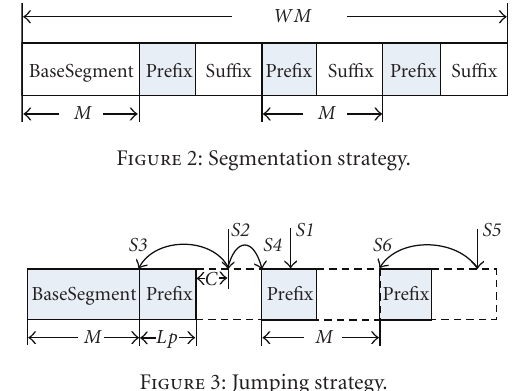
Figure 3: Jumping